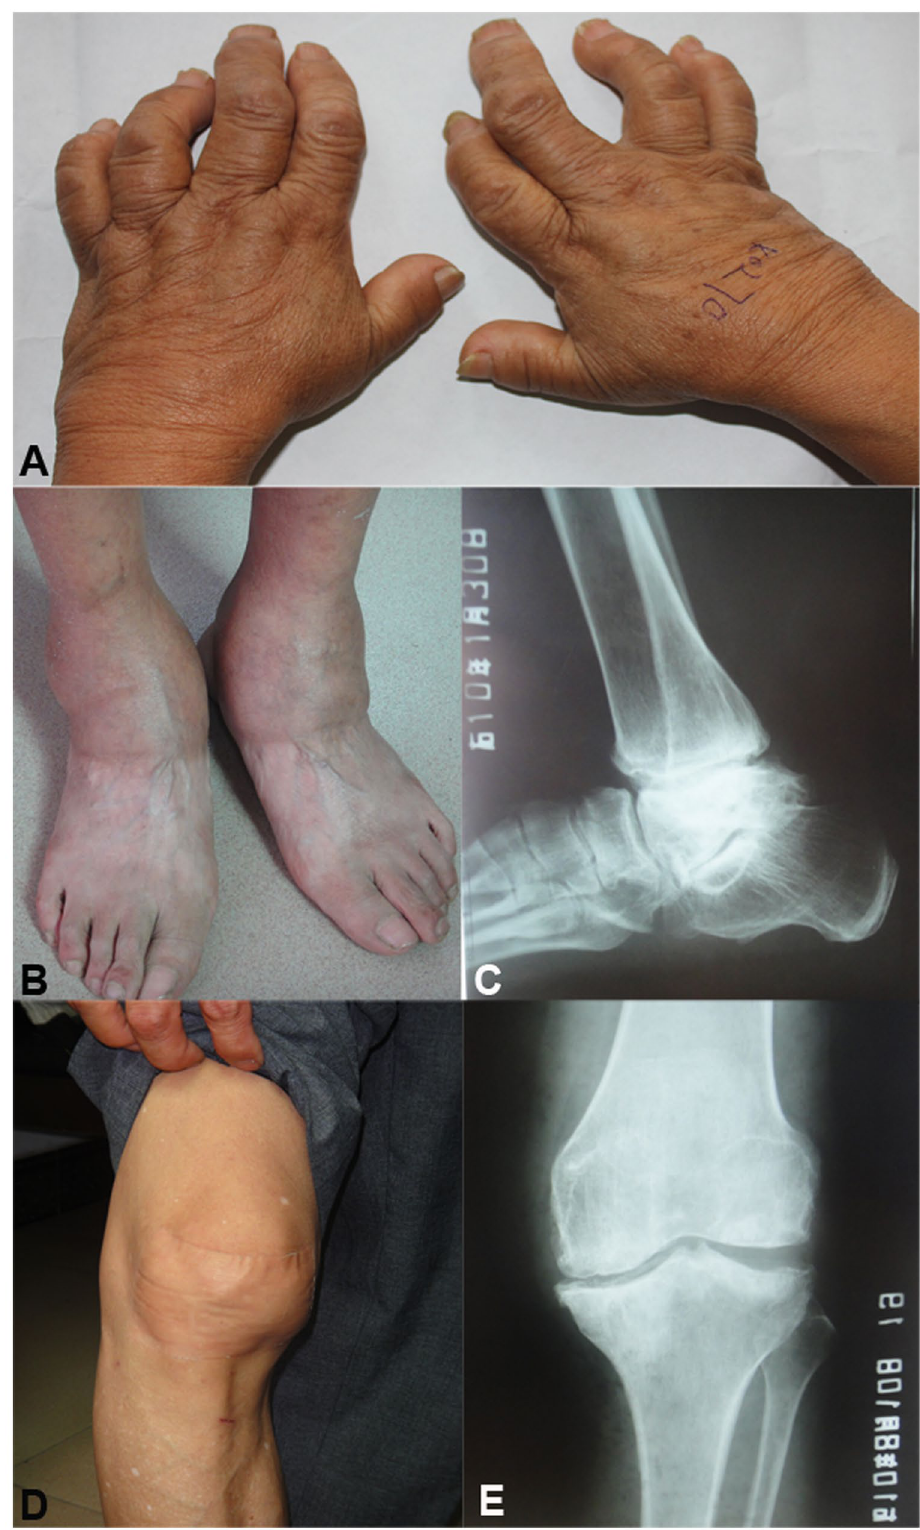
Figure 1. Characteristics of study samples with Kashin-Beck disease. ( A ) Images of hands; ( B , C ) image and radiographic image of ankle; ( D , E ) image and radiographic image of